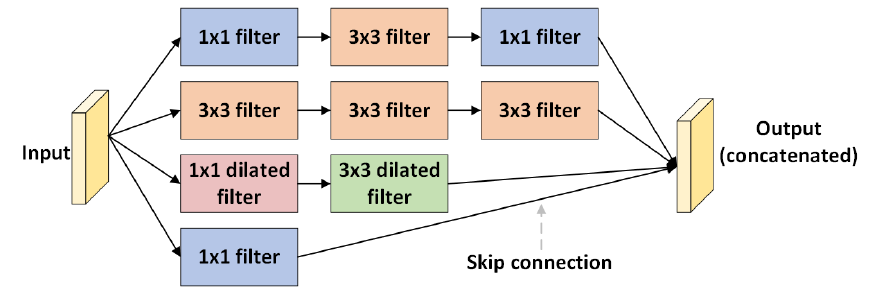
Figure 3. Inception module with different filters for extraction.